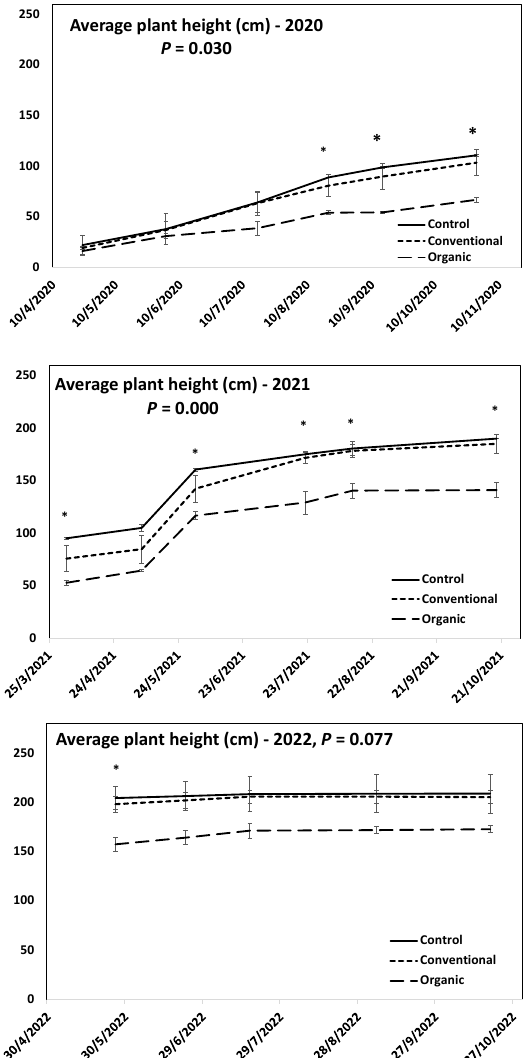
Figure 2. Plant growth patterns expressed as average plant height (cm) for Amelanchier ovalis subsp. ovalis genotype GR-1-BBGK-04,2547 during the three years of the pilot field trial (2020, 2021, and 2022) for the three fertilization treatments applied (control, conventional, and organic). Standard errors of the means are shown on the graphs ( p < 0.05) as well as the respective p values of a repeated-measures ANOVA conducted on treatment effects over time (within-subjects effects) separately for each year ( p < 0.05). Asterisks denote dates when significant differences between treatments were observed following discreet analyses for each measurement date via Tukey’s HSD mean comparison for each year separately ( p <